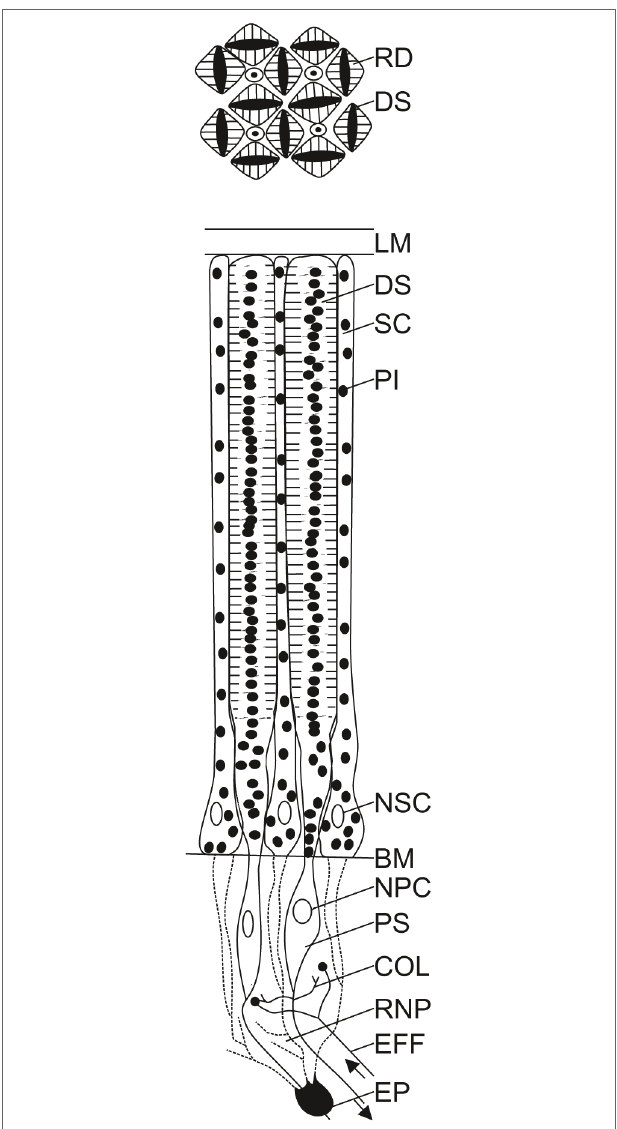
FIGURE 3 | Schematic diagram of the retina of Octopus vulgaris . A limiting membrane (LM) shields the retina towards the posterior chamber. In the distal part of the retina are found the distal segments (DS) of the photoreceptors and supporting cells (SC). Pigment granules (PI) can be found within the photoreceptors and the supporting cells. The cross section through the distal retina (upper diagram), shows the regular arrangement of the distal segments of the photoreceptors (DS) that possess two rhabdomeres (RD) each, facing opposite sides of the cell, and separated by pigment (PI). Four rhabdomeres from four neighboring receptors form a rhabdom. While the nuclei of the supporting cells (NSC) are situated in the distal retina, the nuclei of the photoreceptor cells (NPC) are found in their proximal segments (PS) in the proximal retina, beyond the basal membrane (BM). In the proximal retina, within the retinal nerve plexus (RNP), photoreceptors are interconnected by collateral fibers (COL) from the proximal segments of the photoreceptors, and photoreceptors interact with efferents (EFF) from the optic lobe. Epithelial cells (EP), considered to be retinal glia cells, seem to form processes (dashed lines) that lie between the inner segments of the retinal cells. The schematic diagram of the octopus retina was adapted from previously published drawings (Babuchin, 1864; Schultze, 1867; Grenacher, 1884; Wolken, 1958; Moody and Parriss, 1960, 1961; Young, 1960, 1962b, 1971; Boycott et al., 1965; Yamamoto et al.,